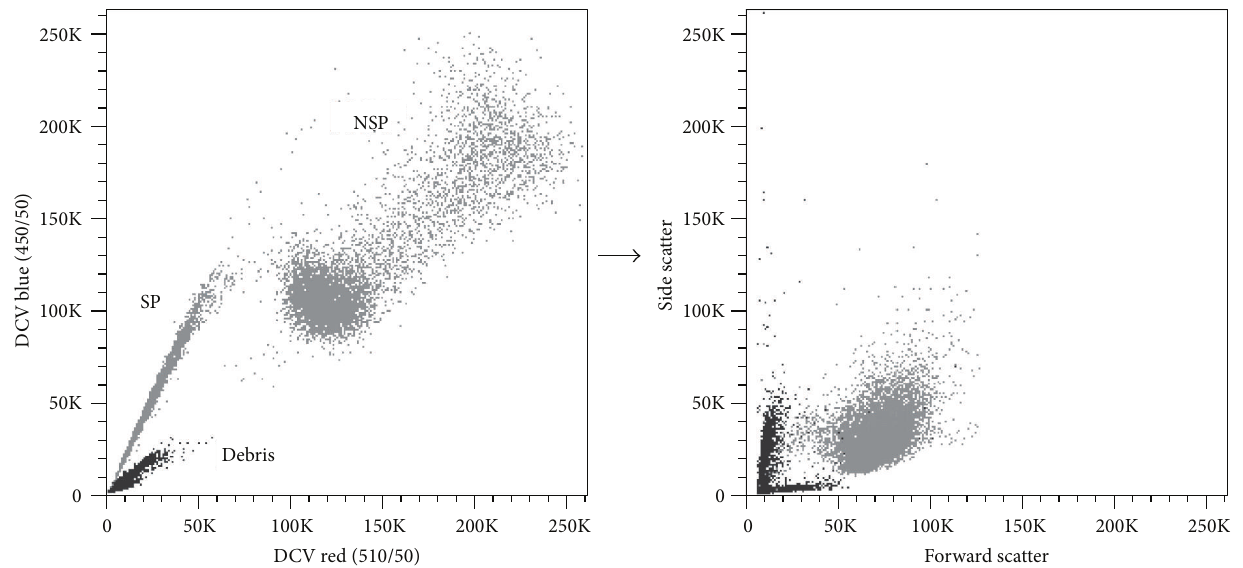
Figure 3: Characteristic localization of debris close to the SP. A2780V cells were stained with 10 𝜇 M DCV (10 6 cells/mL) and analysed by flow cytometry. In this particular case, debris was not properly excluded in the initial forward/side scatter gate to illustrate its location relative to SP and NSP. Debris generally tends to generate a “smear population” in the lower left part of the plot that often shows overlap with the bona fide SP. Thus, debris exclusion by adequate forward/side scatter gating is really crucial in SP